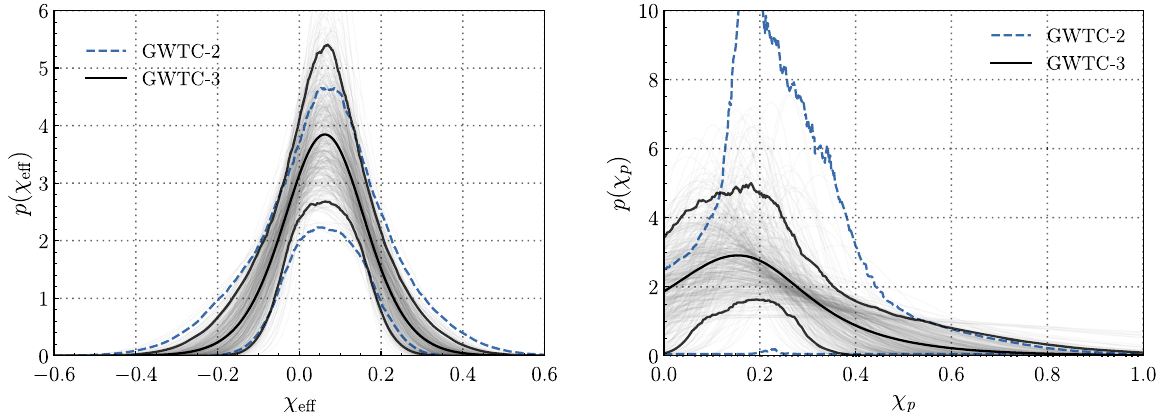
FIG. 16. Left panel: inferred distribution of χ for our latest full analysis in black. For comparison, the blue distribution and interval eff shows our inferences derived from GWTC2. Right panel: corresponding result for χ . While both panels in this figure are derived using p the Gaussian spin model, we find similar conclusions with the other spin models used to analyze